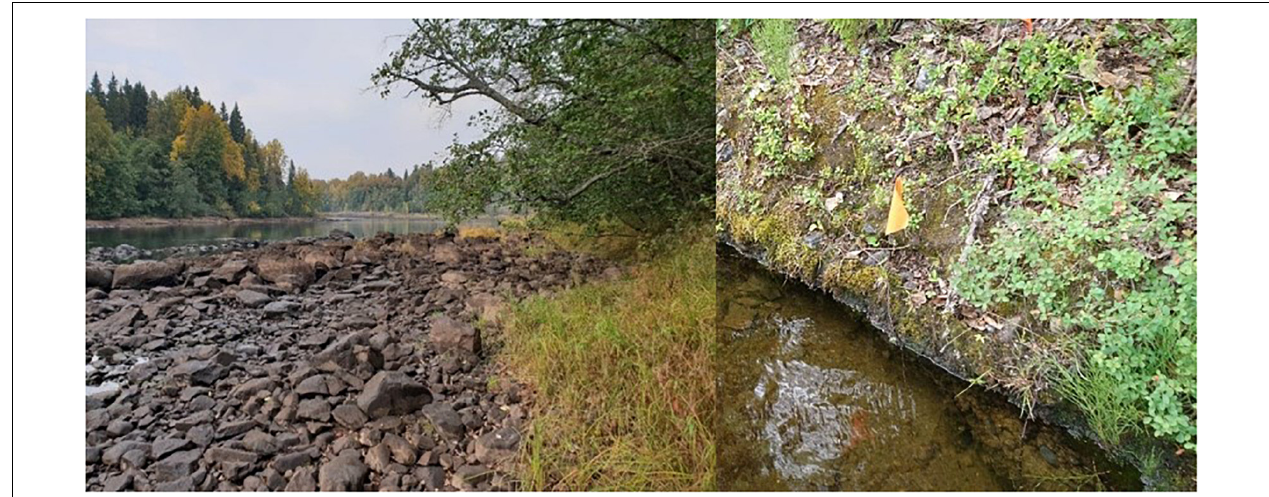
FIGURE 2 | (Left) View over the regulated Västerdal River, Sweden. Photo by LL. (Right) A riparian zone undergoing hydropeaking in Ume River, Sweden. Photo by JH.